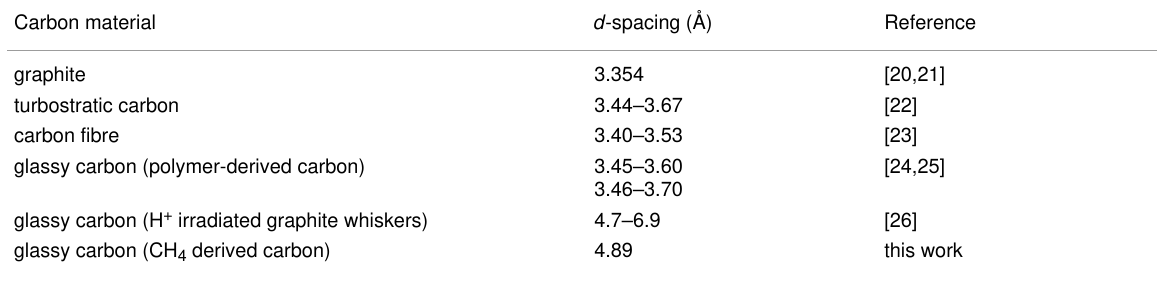
Table 1: Interlayer spacing data characteristic for selected carbon